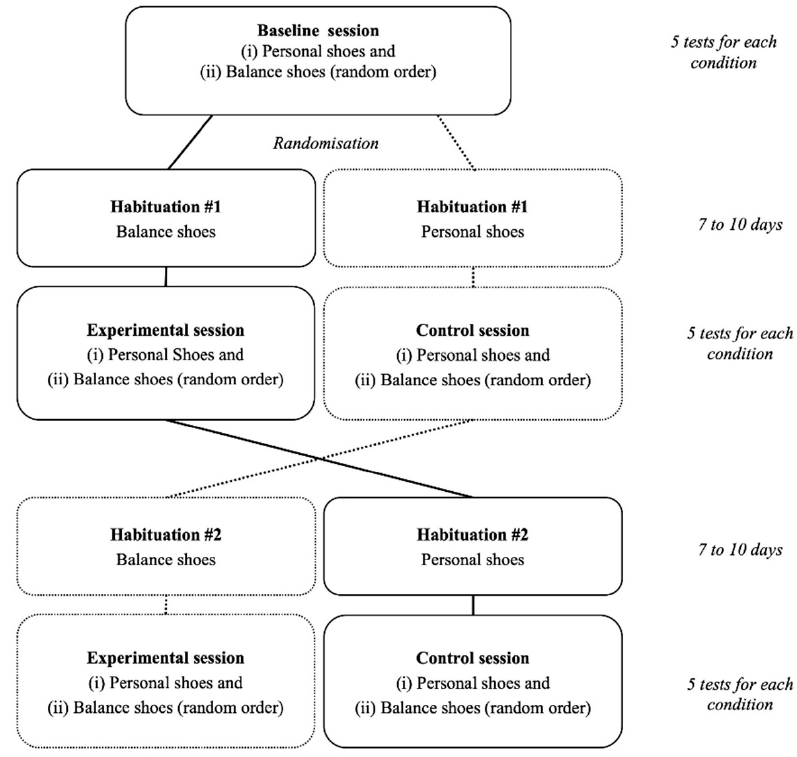
Figure 1. Experiment design.